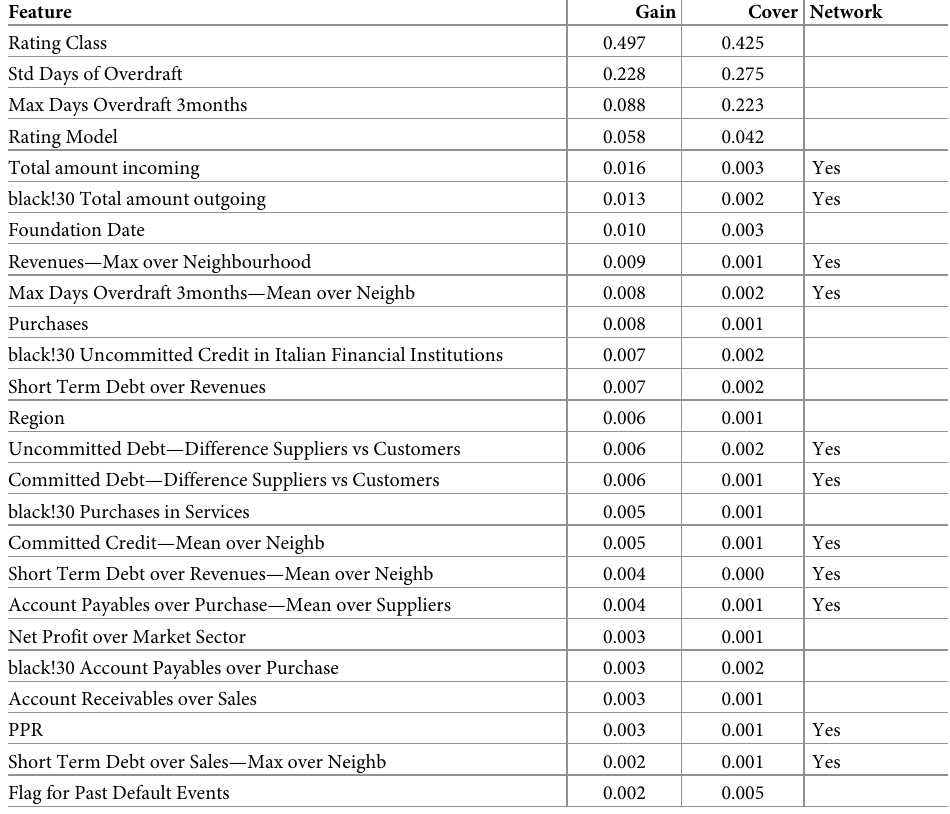
Table 3. Feature importance of the XGBoost model sorted by information gain. Several network features populate the top of the list (the column Network indicates whether the feature is a network